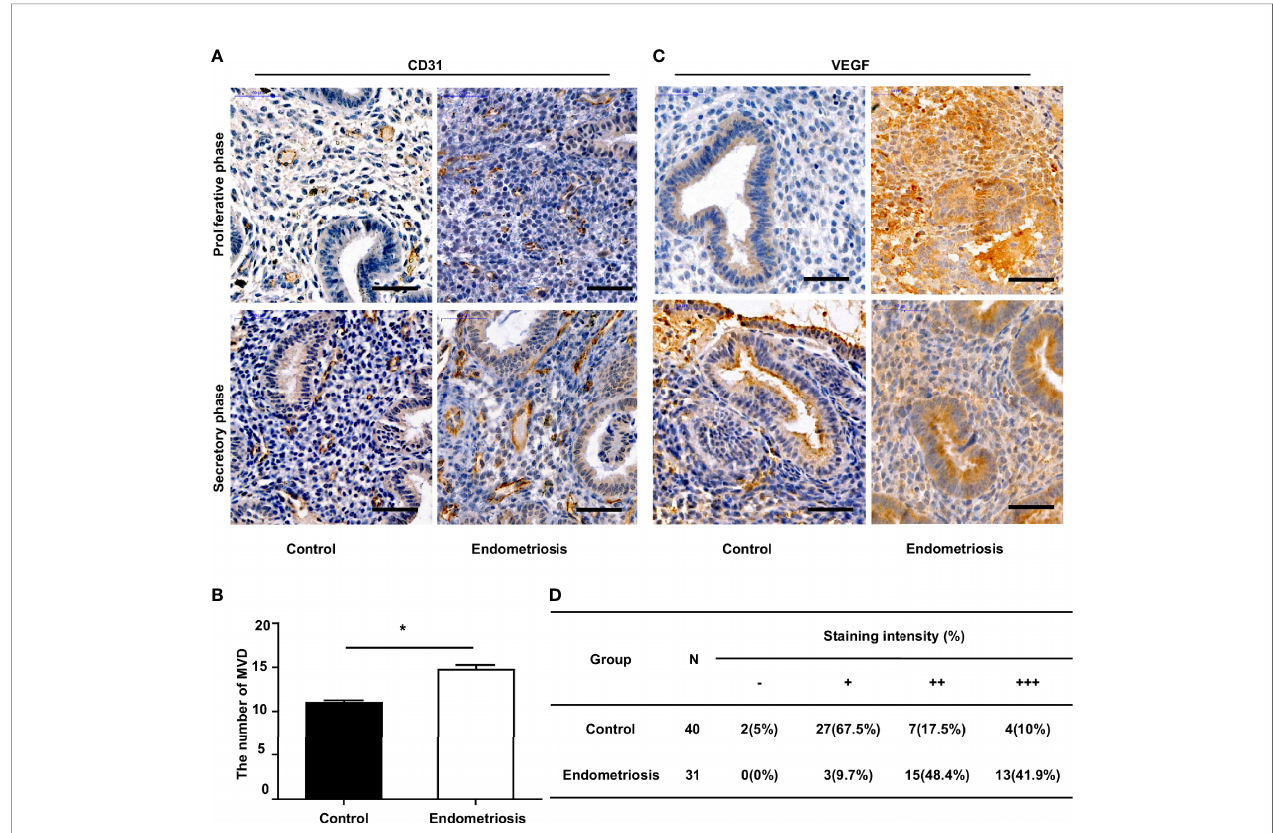
FIGURE 1 | Increased MVD level and VEGF expression in the eutopic endometrium of endometriosis patients. (A) Representative immunohistochemical images of CD31 staining in eutopic endometrium of endometriosis patients and normal endometrium of patients without endometriosis (control), bar=50µm. (B) Quantitative analysis of MVD levels between endometriosis and control group. (C) Representative immunohistochemical images of VEGF staining in eutopic endometrium of endometriosis patients and normal endometrium of patients without endometriosis (control), bar=50µm. (D) Percentages of different staining intensities of VEGF in endometriosis and control group. * P